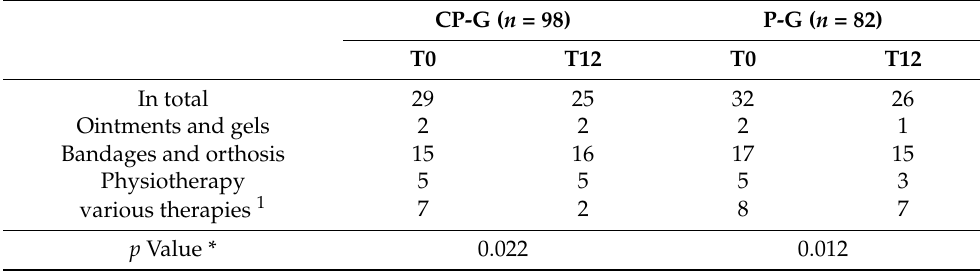
Table 4. Additional therapies in the PP